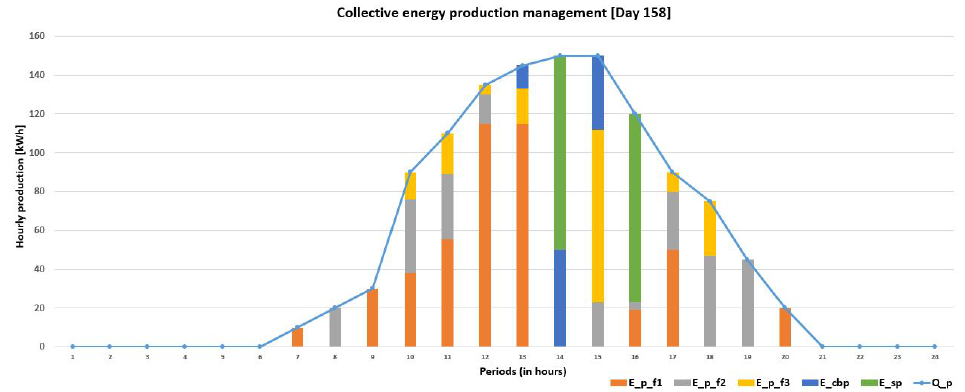
Figure 8. Collective energy production management during day